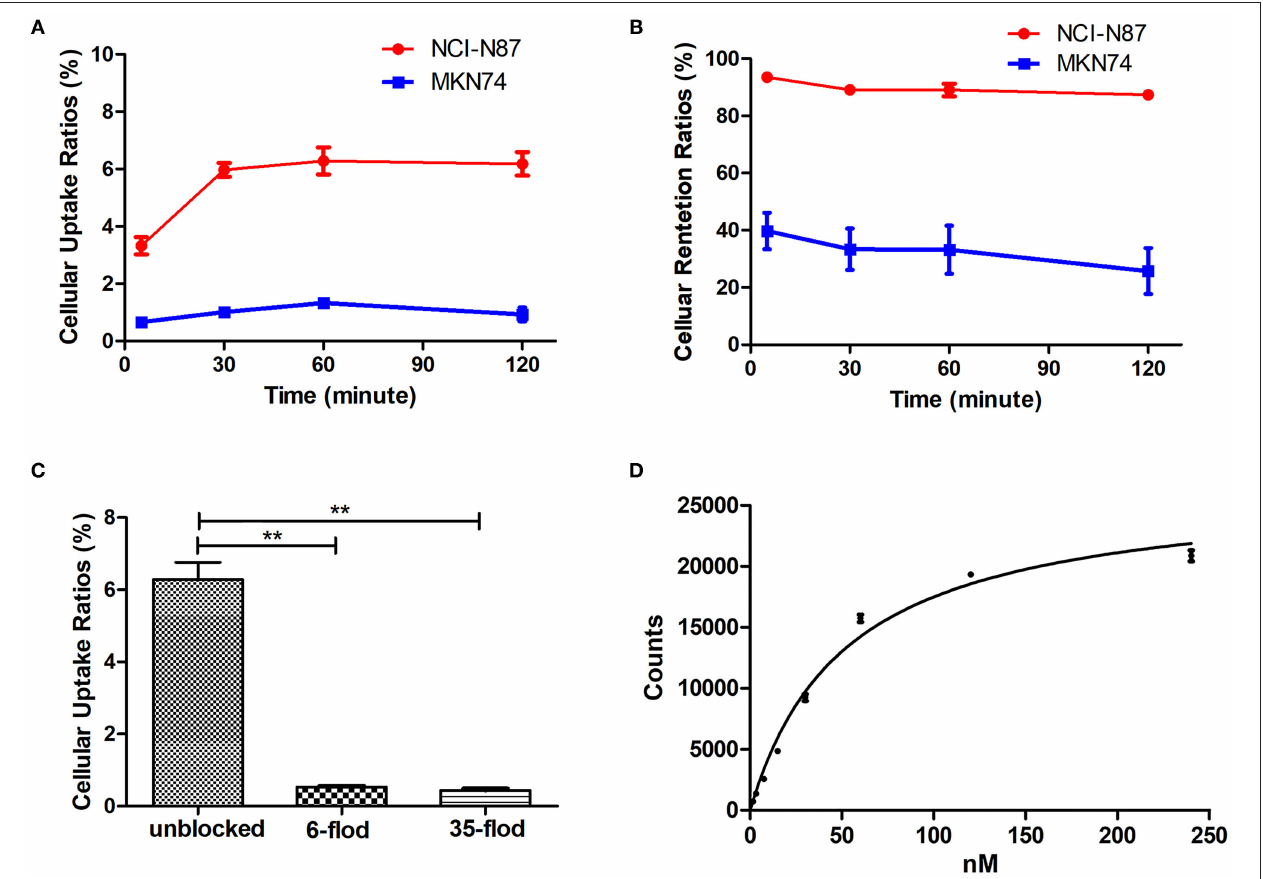
FIGURE 3 | Cellular uptake (A) , and retention kinetics (B) of the [ 18 F]AlF-NOTA-HER2 affibody in NCI-N87 and MKN74 cells. Blockade of the cellular uptake of the [ 18 F]AlF-NOTA-HER2 affibody in NCI-N87 cells (C) (** p < 0.01). Binding saturation curve of the [ 18 F]AlF-NOTA-HER2 affibody to HER2 in NCI-N87 cells (D) .